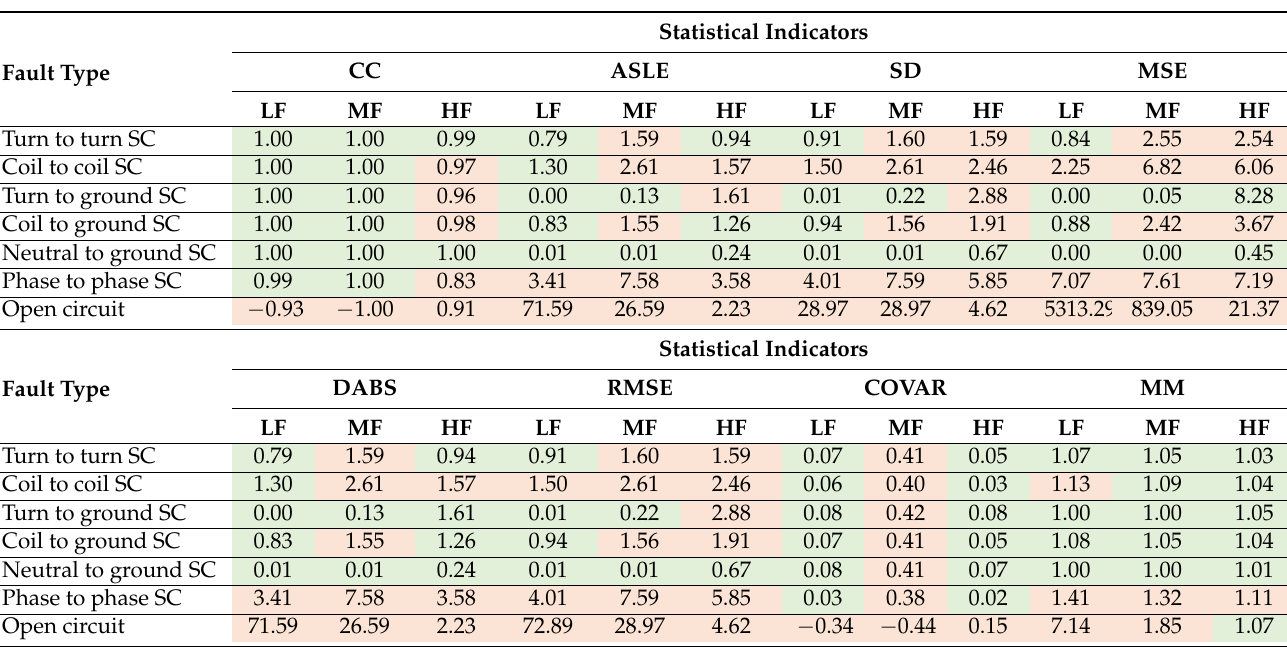
Table 8. Statistical indicators for normal and faulty FRA signatures of the tested IM with star stator winding.